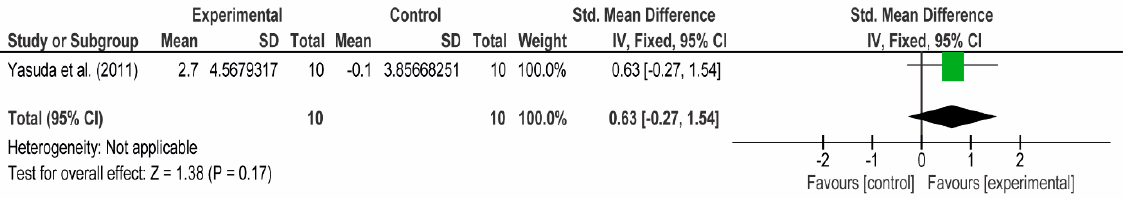
Figure 6. The effect size of low-intensity bench press training with blood-flow restriction on the pectoralis major CSA.